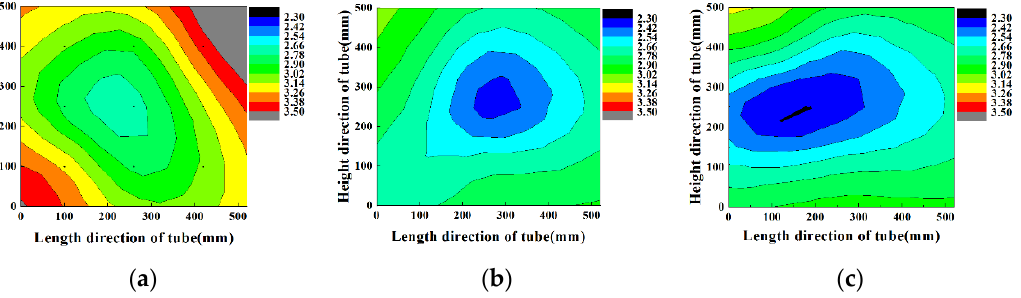
Figure 4. Velocity distribution of air inlet under different plenum-chamber coefficients: ( a ) velocity distribution of air inlet at Φ = 0.74; ( b ) velocity distribution of air inlet at Φ = 0.97; ( c ) velocity distribution of air inlet at Φ =